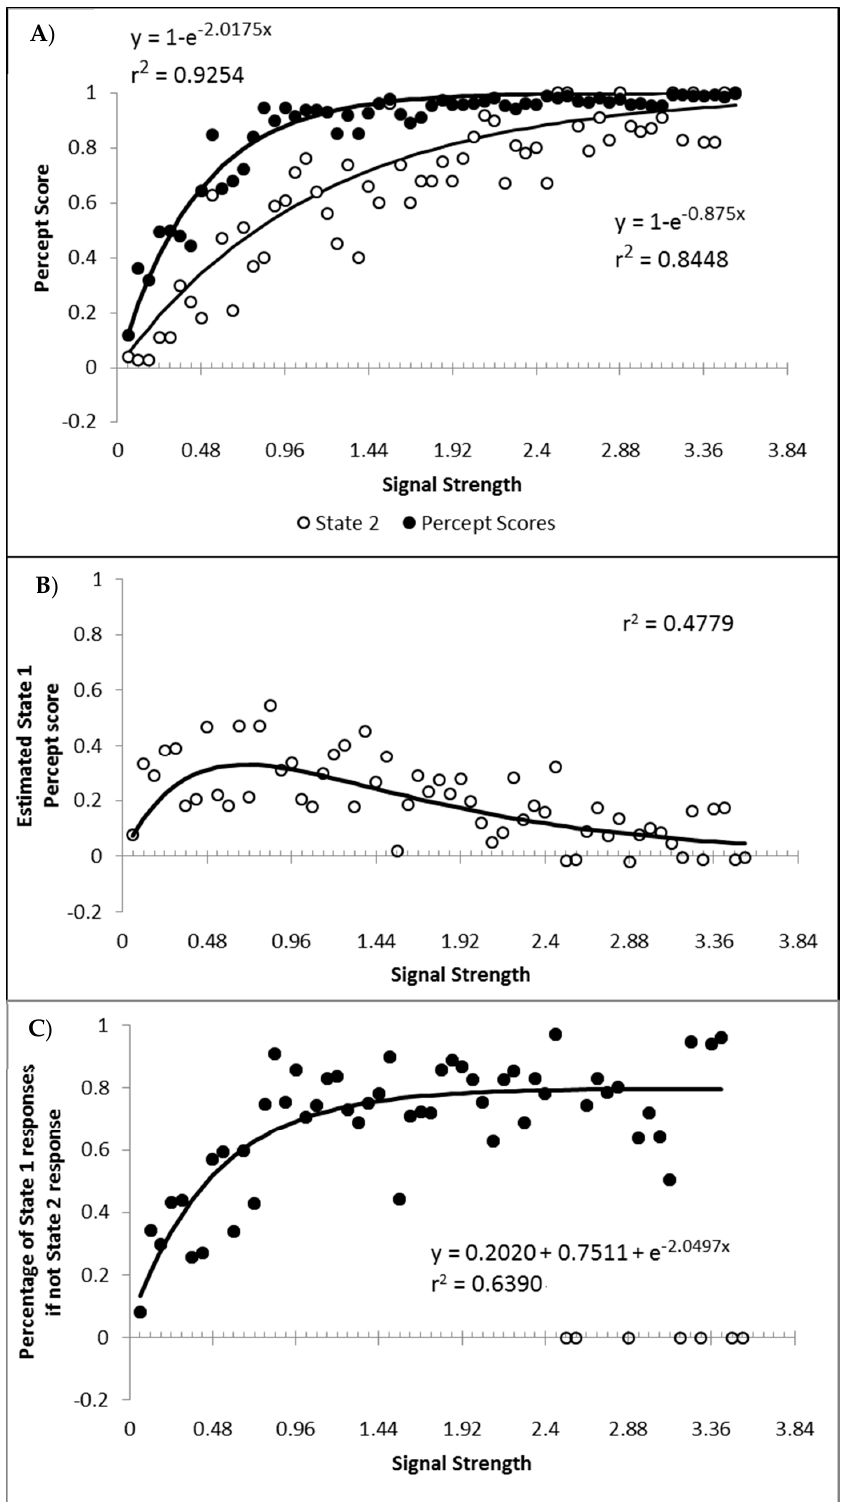
Figure 11. Shown as a function of signal strength, are ( A ) the percept scores (filled symbols) and the estimated proportion of state 2 responses and ( B ) the estimated proportion of total trials requiring state 1 responses, assuming the best possible performance from state 2 responding, ( C ) the estimated proportion of non-state 2 trials requiring state 1 responses, assuming the best possible performance from state 2 responding.